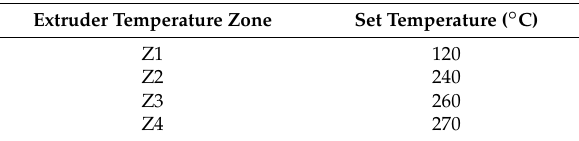
Table 2. Profile settings.